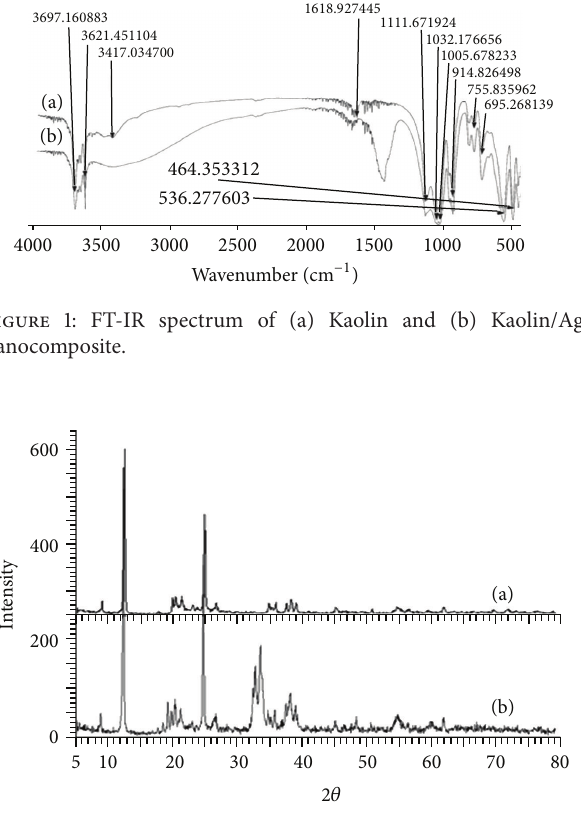
Figure 2: XRD patterns of (a) Kaolin and (b) Kaolin/Ag nanocom-